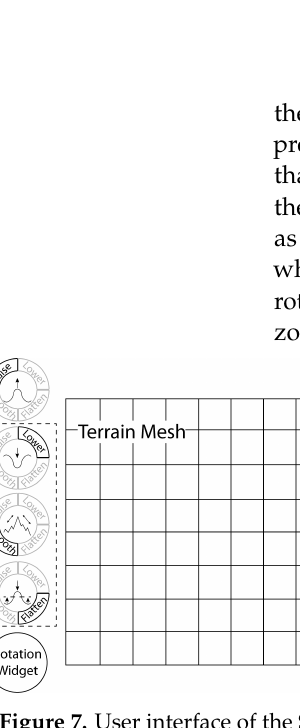
Figure 7. User interface of the ShAREdT-based collaborative application for terrain sketching, where avatars on the terrain mesh denote the identity, location, and current action of participants in a collaborative